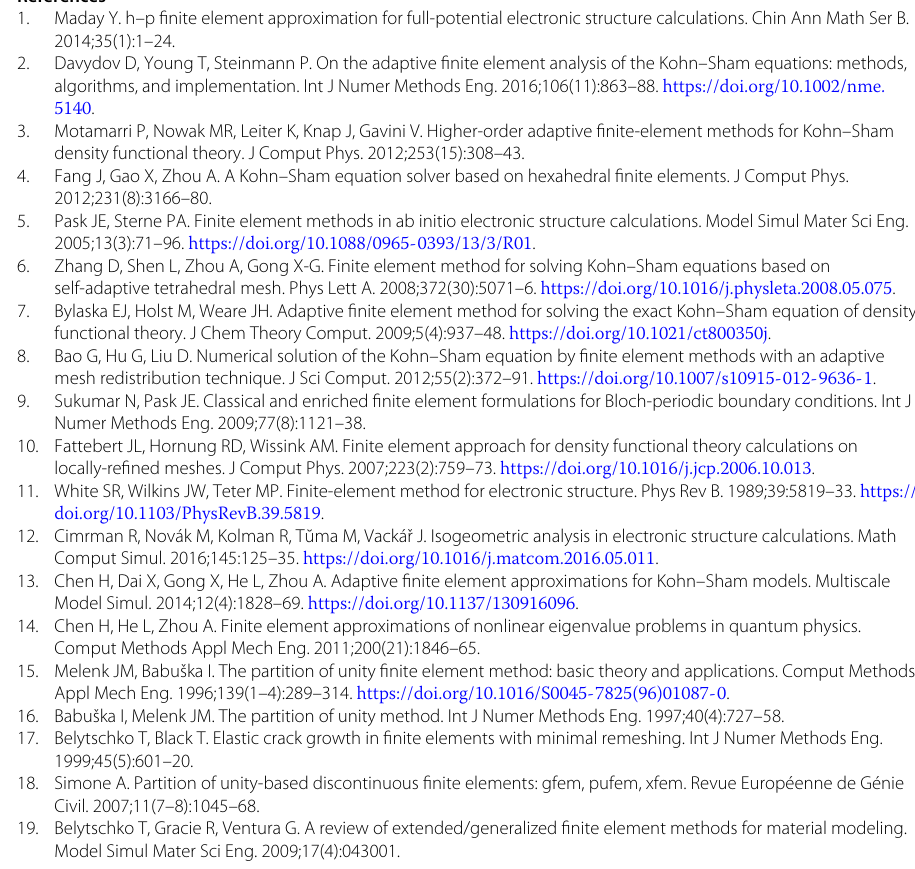
tion in continuum mechanics. Figure 9 depicts an example of enriched and non-enriched shape functions for the case of h -adaptive refinement with hanging nodes in two dimen-